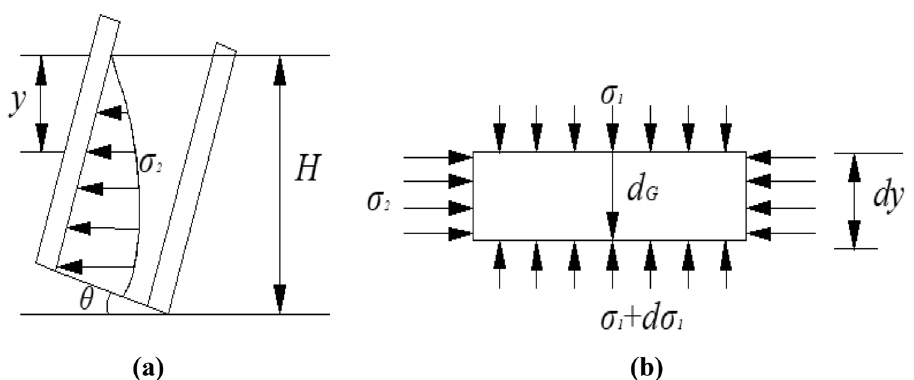
Figure 5. The stress distribution unit of the seed-filling